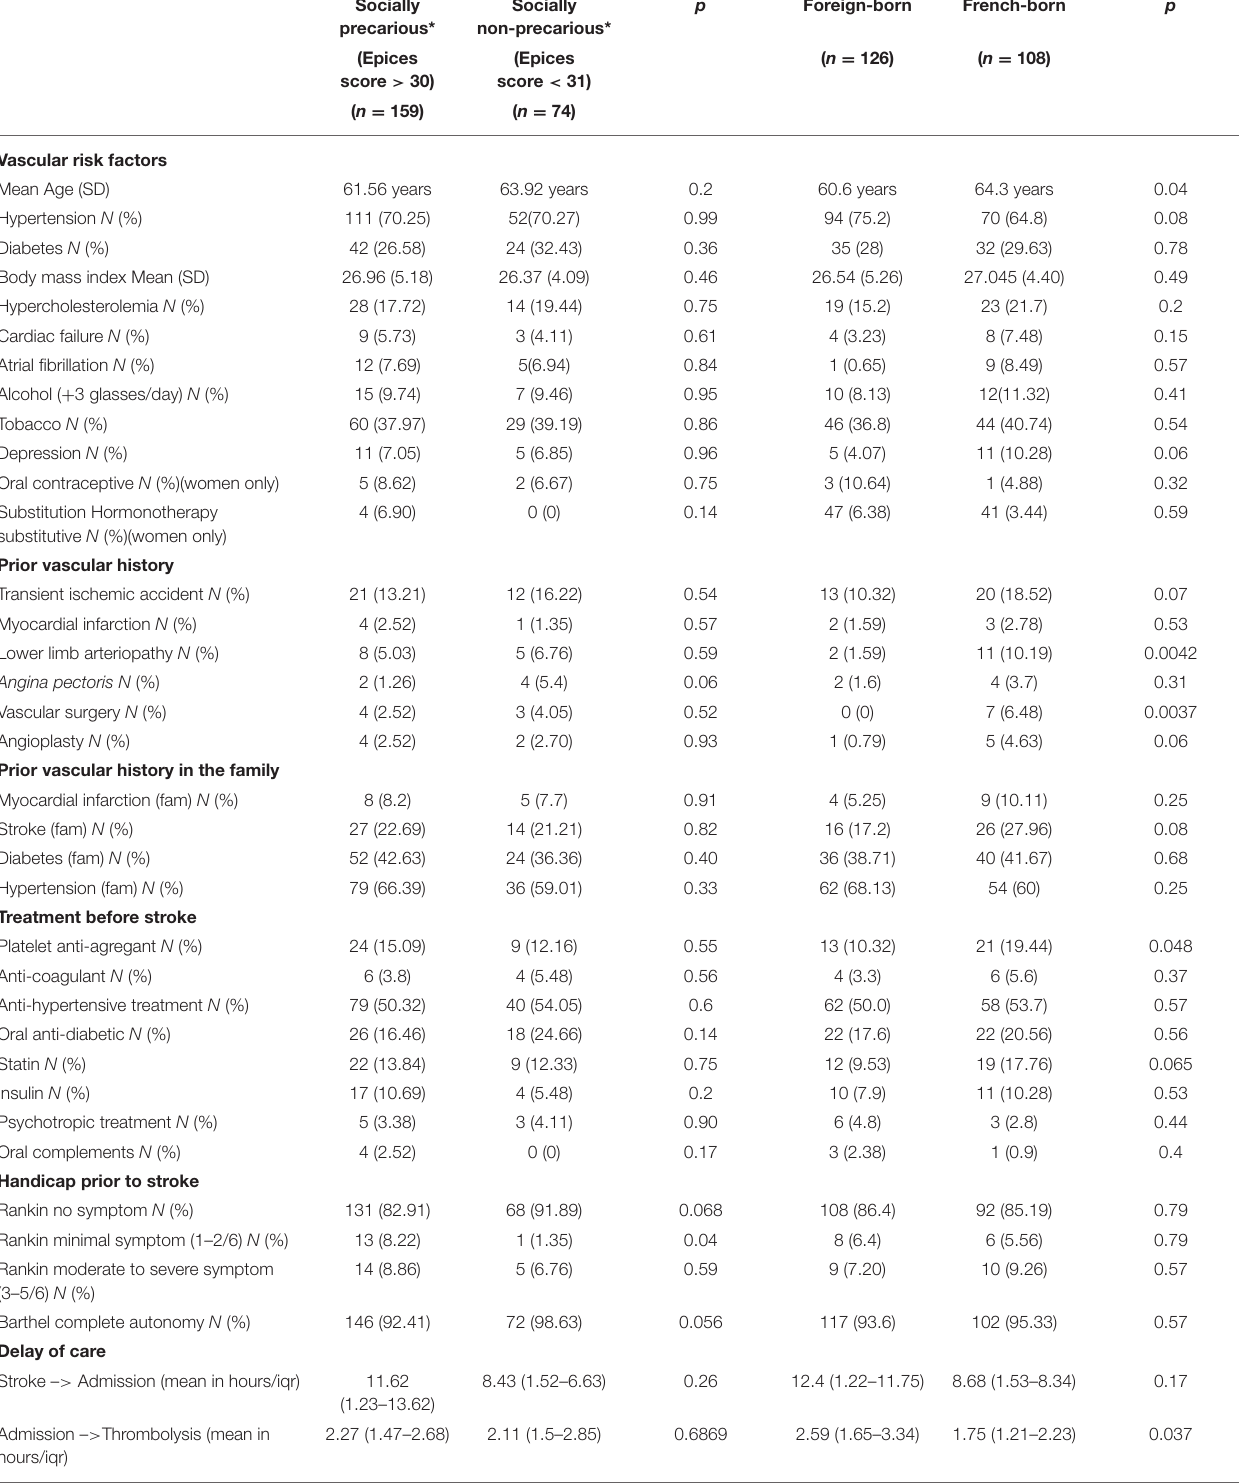
TABLE 3 | Comparisons between precarious and non-precarious patients within French Guiana.